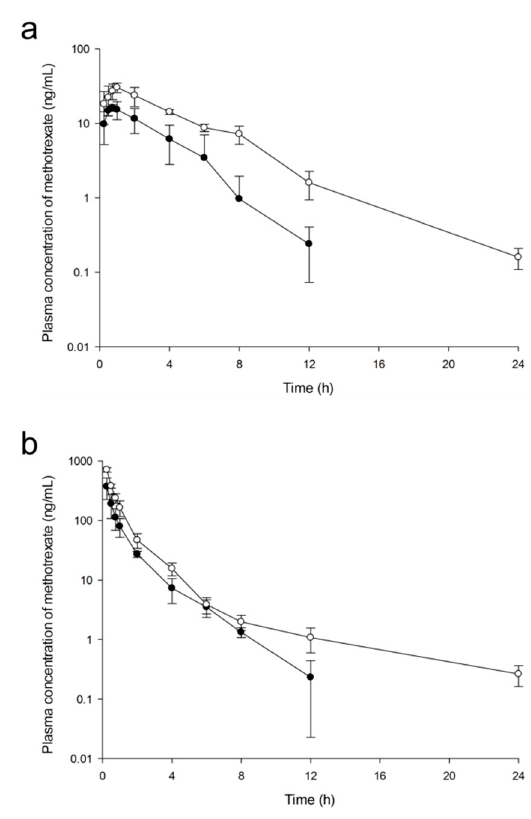
-, 5 mg / kg as MTX) (cid:35)